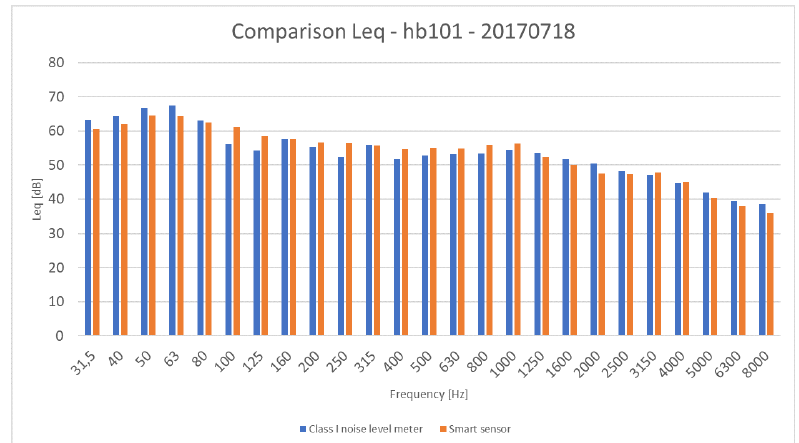
Figure 5: Broad band check (by using road traflc noise), considering 7 minutes as measurement time period – One third octave band sound pressure levels, in terms of Leq,10’ [dB]